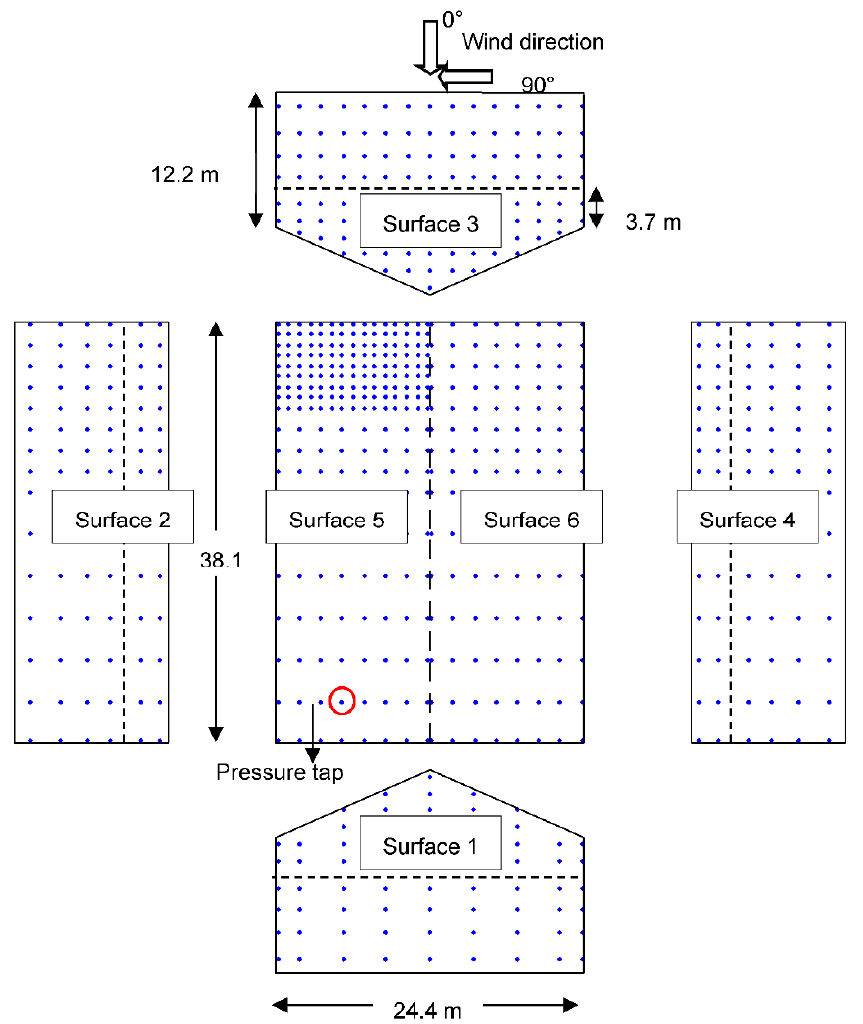
Figure 2. Pressure tap layout in the wind tunnel model.